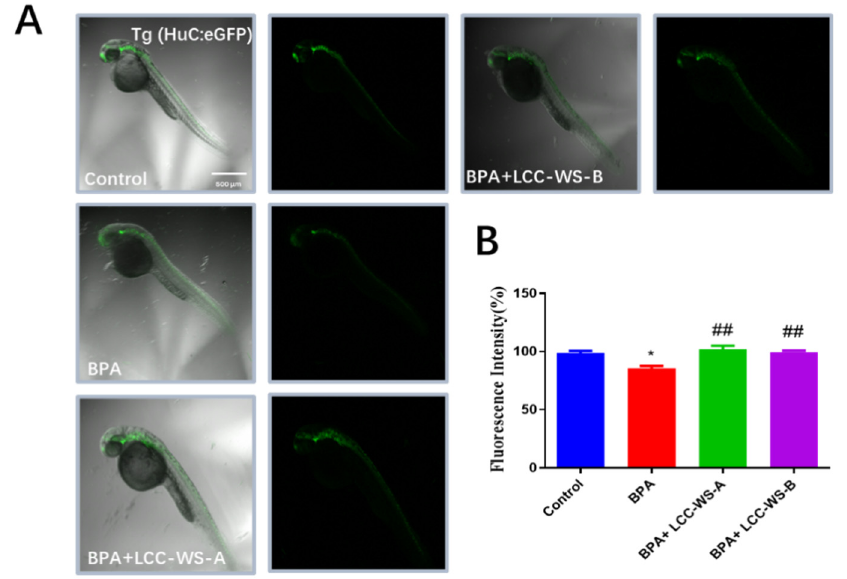
Figure 6. Effects of LCC-WS-A and LCC-WS-B on neurogenesis in Tg (HuC-GFP) zebrafish. Green fluorescence images of neurogenesis in 72 hpf Tg (HuC-GFP) zebrafish ( A ) and statistical analysis of fluorescence ( B ) ( n = 10 in each group). * p < 0.05, compared with the control group. ## p < 0.01, compared with the BPA-treated group.